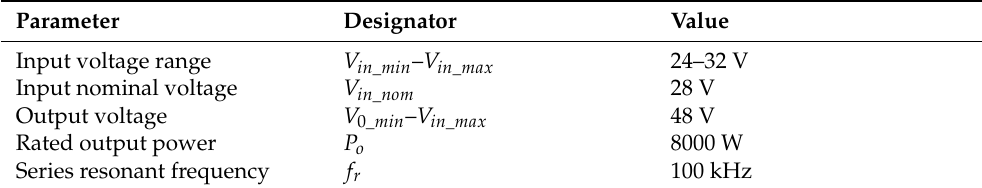
Table 1 summarizes the system requirements for a typical LLC-RC application. Table 1. System